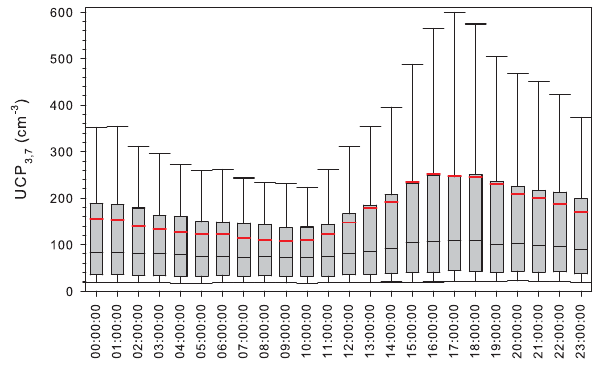
Fig. 9. Mean diurnal cycle of the UCP 3 , 7 concentrations. For de- scription of the symbols see Fig.